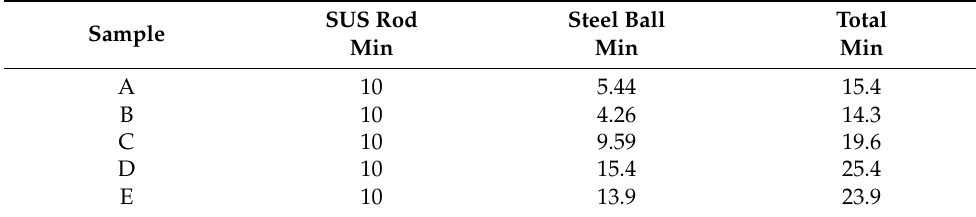
Table 2. Grinding time to produce P 80 of 170 µ m for flotation